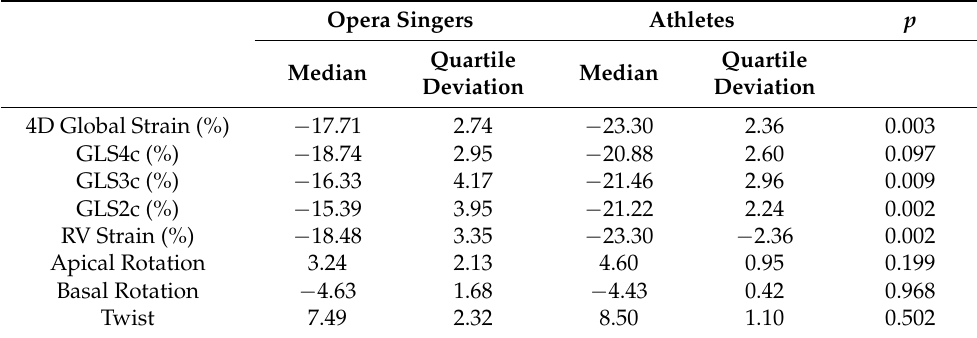
Table 2. Echocardiographic strain and twist parameters of opera singers and athletes.